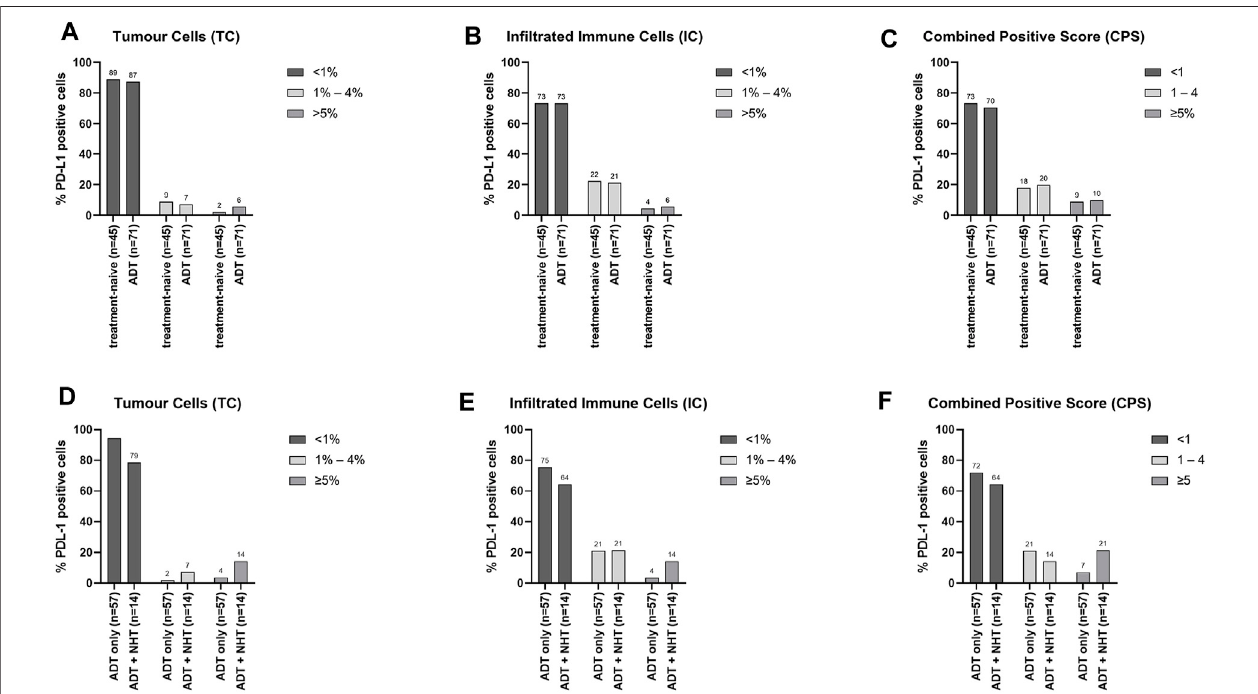
FIGURE4| In fl uenceofADTonPD-L1expression onTCand IC(A+B+C)Graphicalillustration ofthein fl uenceofADTonthedistributionofPD-L1expression on (A) tumour cells (TC), (B) in fi ltrating immune cells (IC), and the resulting (C) combined positive score (CPS). The “ treatment-naïve ” cohort included 45 samples and the “ ADT ” cohort 71 samples. (D + E + F) Graphical illustration of the in fl uence of additional treatment with NHT on the distribution of PD-L1 expression on (D) tumour cells (TC), (E) in fi ltrating immunecells(IC),andtheresulting (F) combined positivescore(CPS). The “ ADTonly ” cohortincluded 57samplesandthe “ ADT+NHT ” cohort 14 samples. Numbers are displayed as column bar